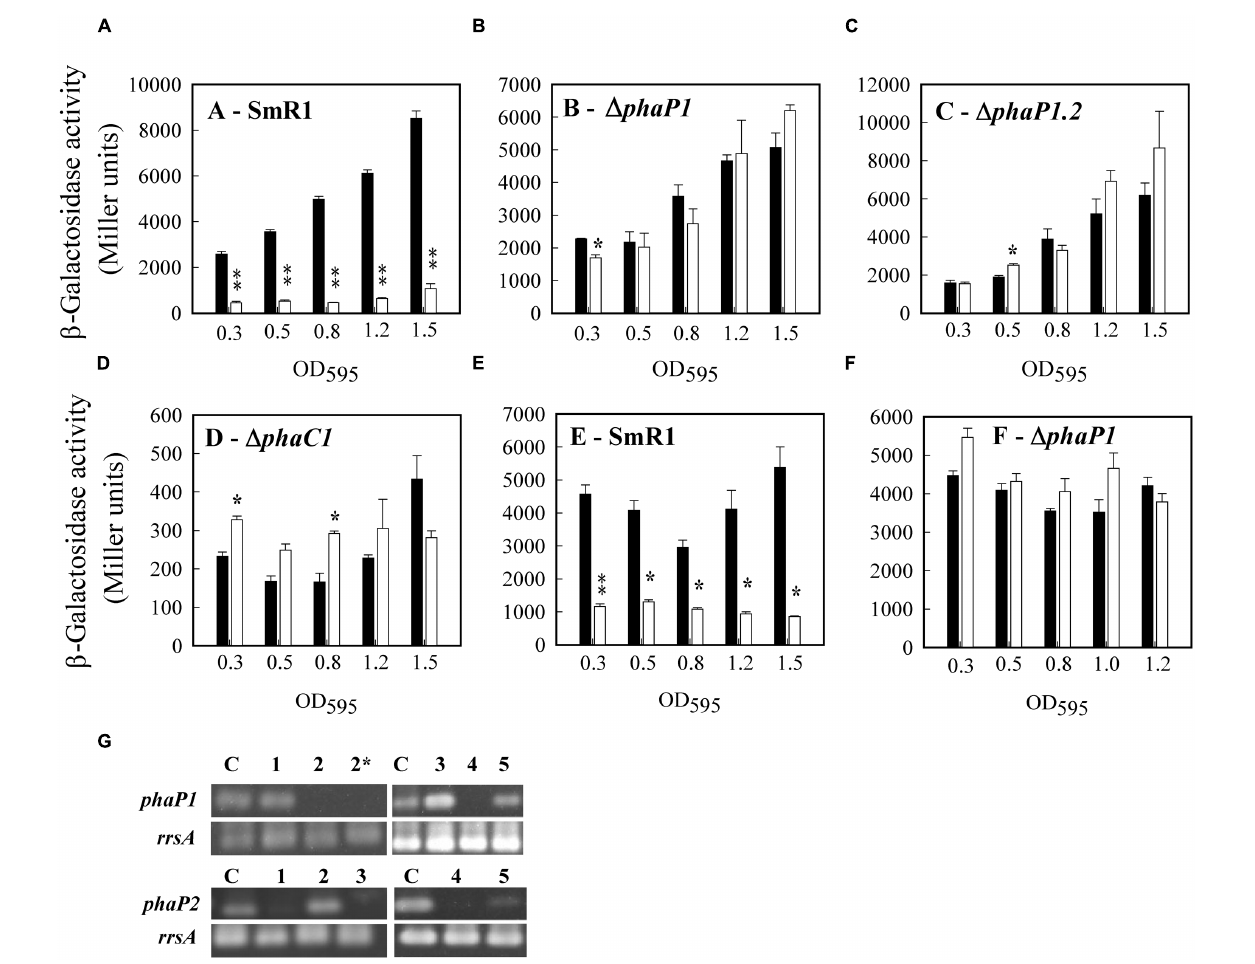
FIGURE 4 | Transcriptional analyses of phaP1 and phaP2 expression in H. seropedicae . (A–D) Cells harboring P phaP 1- lacZ (black bars) or P phaP2 - lacZ (white bars) were grown in liquid NFb medium containing 37 mM DL -malate and 20 mM NH 4 Cl at 30 ◦ C. (E,F) Cells harboring P phaP 1- lacZ (black bars) or P phaP 2- lacZ (white bars) were grown in liquid cultures of NFb containing 25 mM D -glucose and 20 mM NH 4 Cl at 30 ◦ C. When the OD 600 of the cultures reached the indicated values, 100 µ L of culture was removed to determine β -galactosidase activity. H. seropedicae strains harboring pMP220 (promoterless lacZ plasmid) gave an average activity of 50 Miller units in all growth phases analyzed. Experiments were performed in biological triplicates. The means of β -galactosidase activity were tested in pairs for each sample point. Where appropriate, statistical significance is shown ( ∗ p -value ≤ 0.05, ∗∗ p -value ≤ 0.01, independent two-sample t -test). (G) RT-PCR analysis. The RNA from the strains SmR1 (lane 1), (cid:49) phaP1 (lane 2 and 2 ∗ for phaP1 , lane 2 for phaP2 ), (cid:49) phaP2 (lane 3), (cid:49) phaP1.2 (lane 4), and (cid:49) phaC1 (lane 5) was purified and submitted to direct RT-PCR amplification of phaP1 and phaP2 gene as described in Methods. The lane C is a PCR product amplified from gDNA from H. seropedicae SmR1 used as positive control of the reaction. The 16S rRNA ( rrsA ) was used as an endogenous expression control. A representative gel from tree independent RNA extractions is